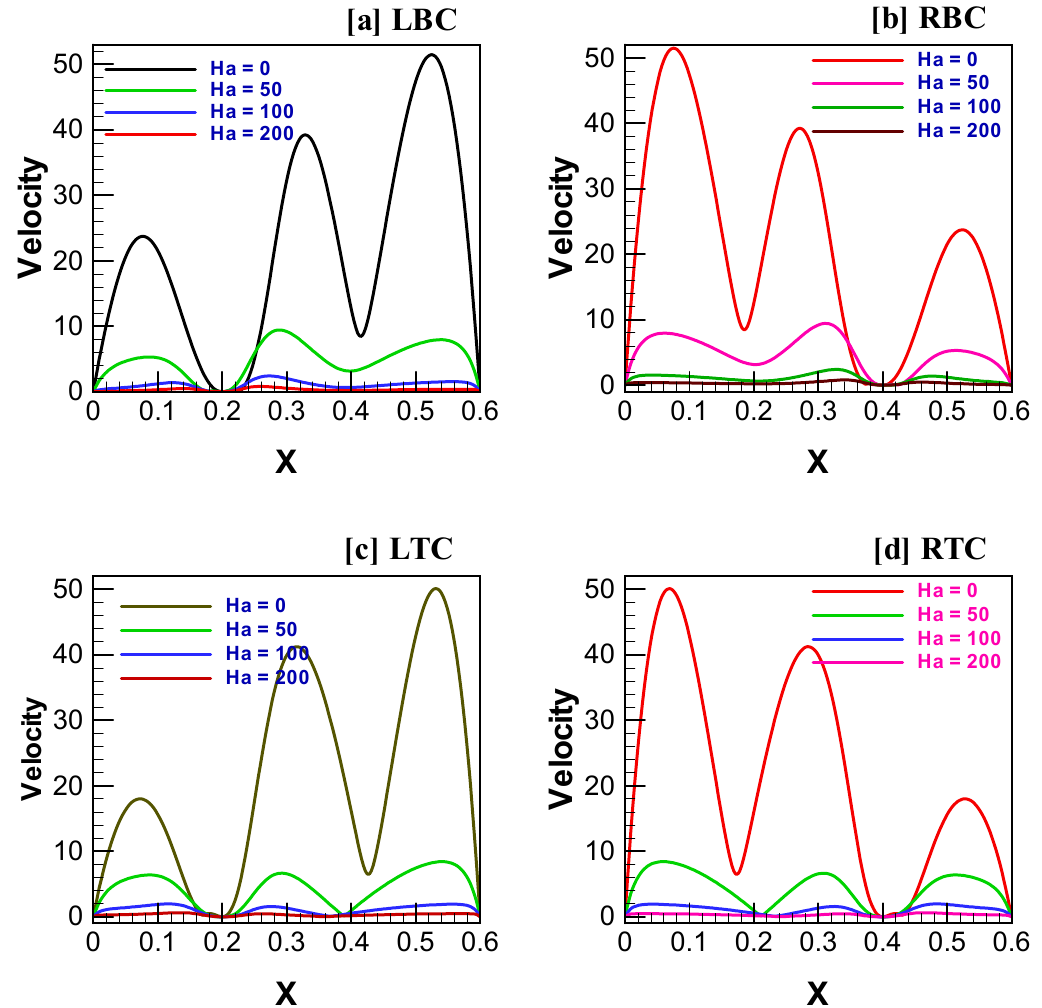
Figure 9. Variations of velocity vs. distance for different orientations of heated cylinders for Ha = 0–200, Ra = 10 5 and Pr = 0.71 .